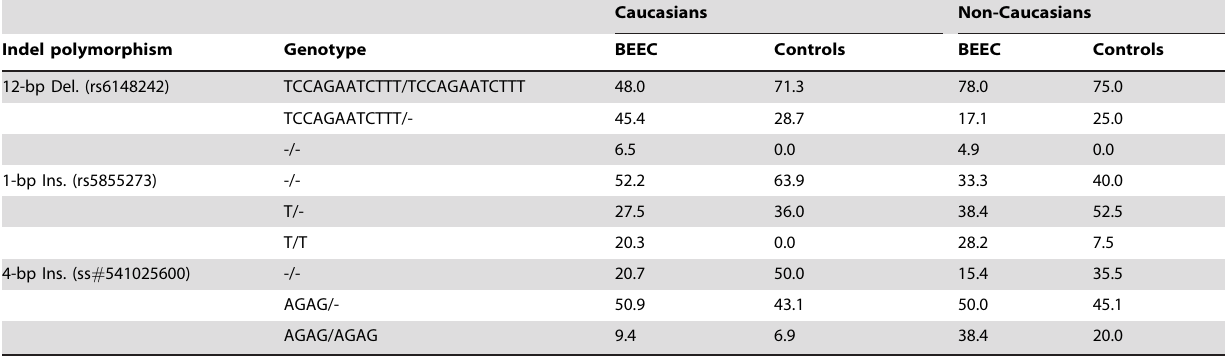
Frequency (%) of indel genotypes in Caucasian and non-Caucasian